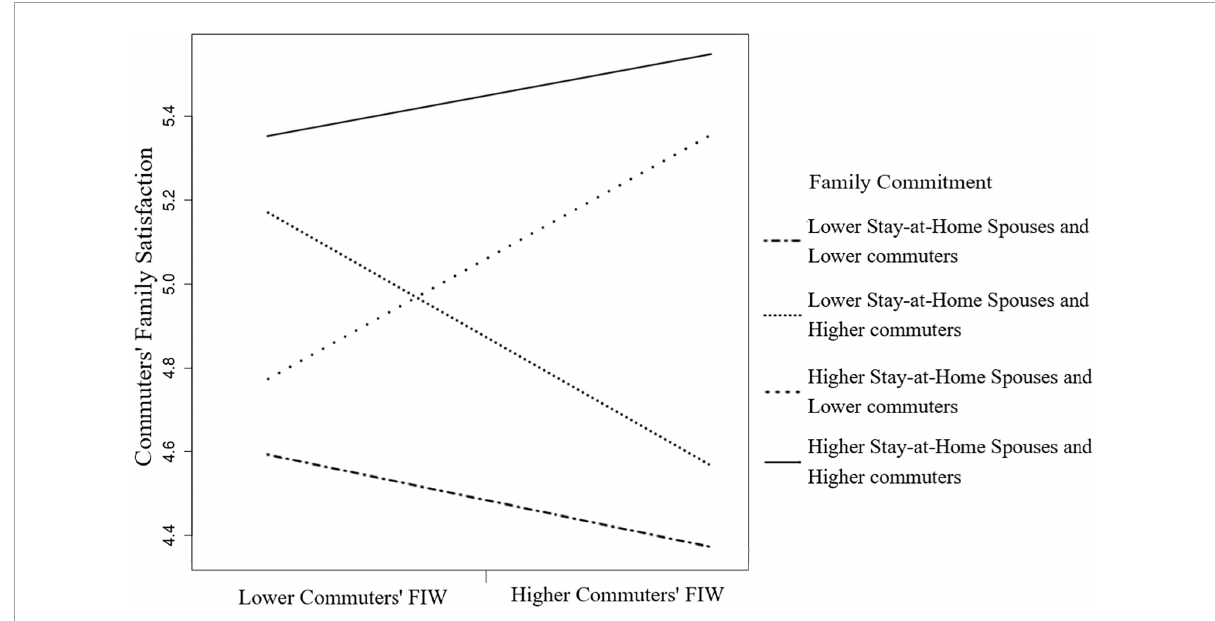
FIGURE6 Four combinations of family commitment on commuters’ FIW and family satisfaction